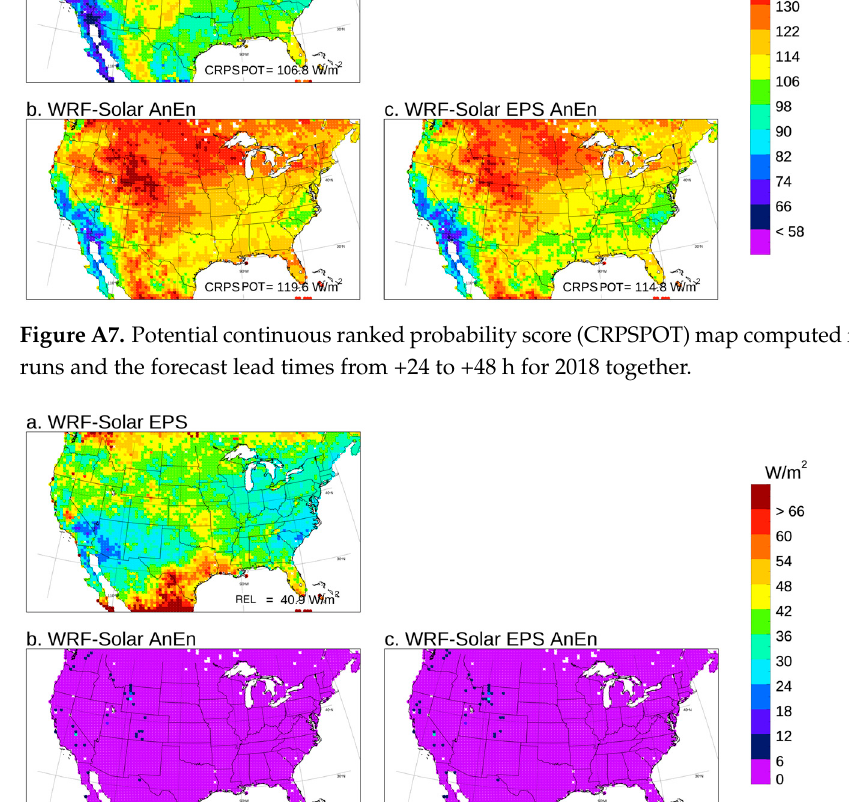
Figure A8. Reliability (REL) map computed for DNI pooling runs and the forecast lead times from +24 to +48 h for 2018 together.